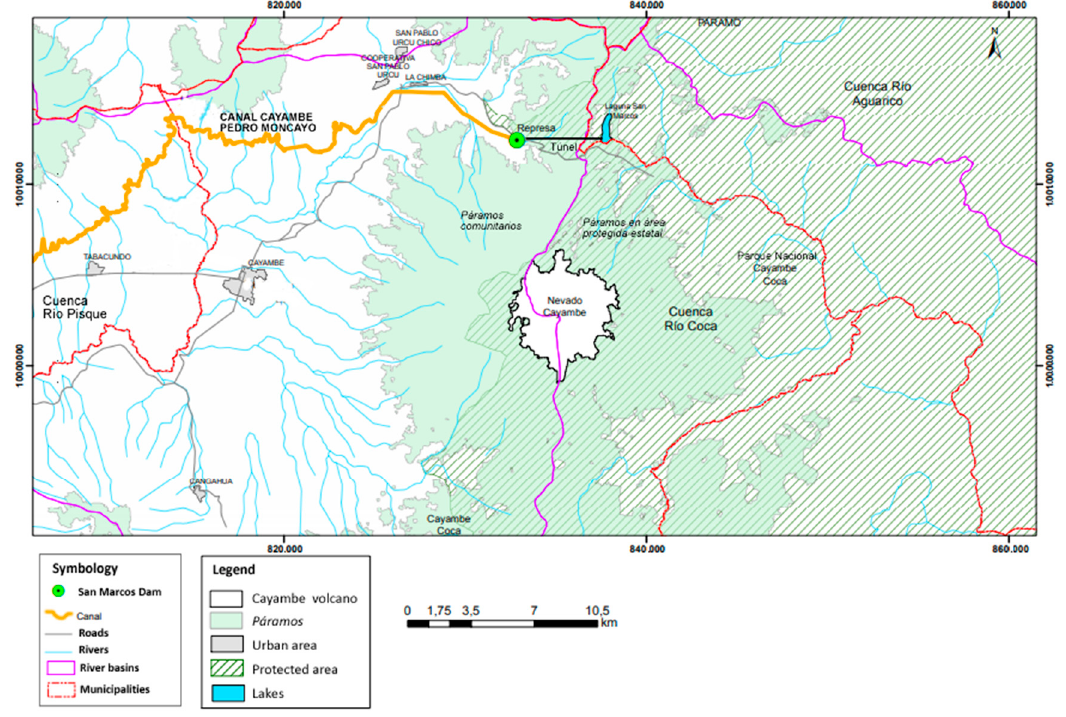
Figure 1. The La Chimba community páramos around the snow-capped Cayambe, inside and beyond the protected area, and the hydraulic irrigation works.